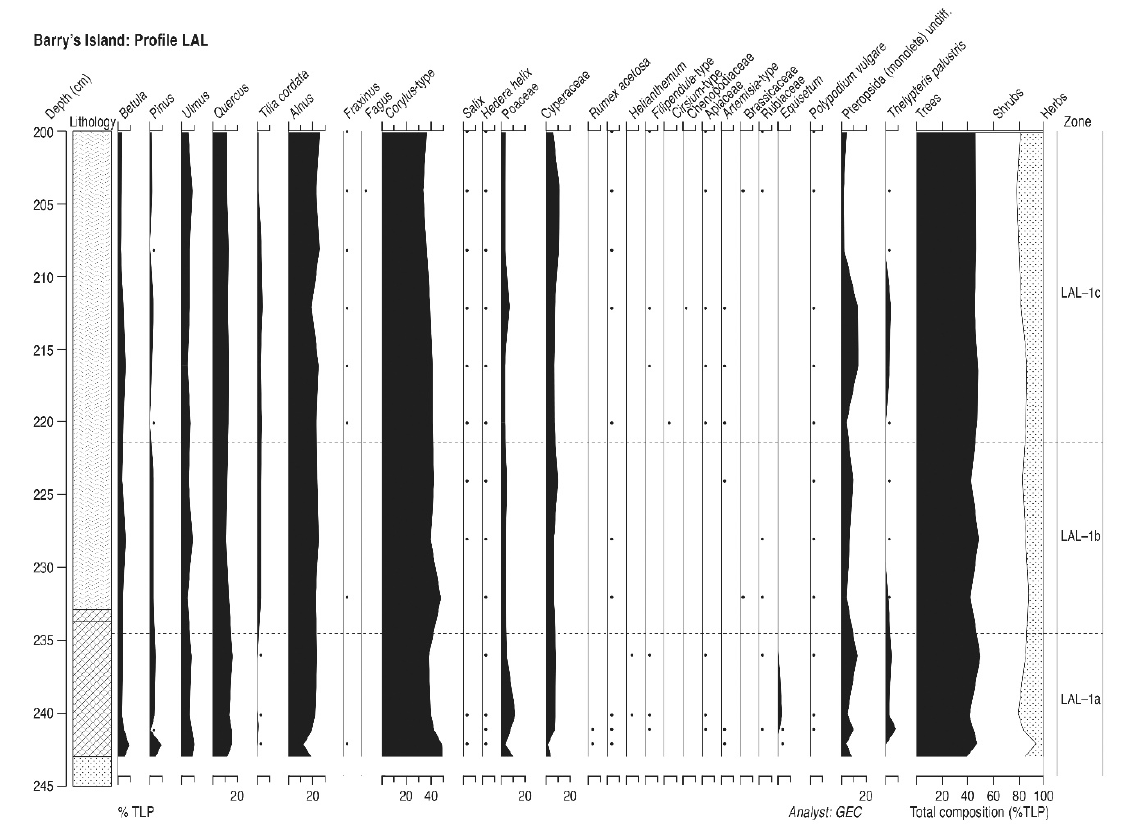
Figure 11. Percentage pollen diagram from Barry’s Island profile LAL. (Analysis GEC).